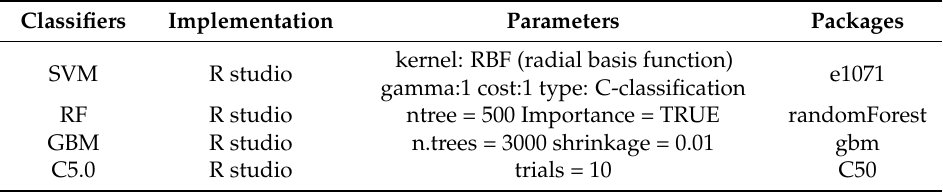
Table 2. Classification algorithms and parameter